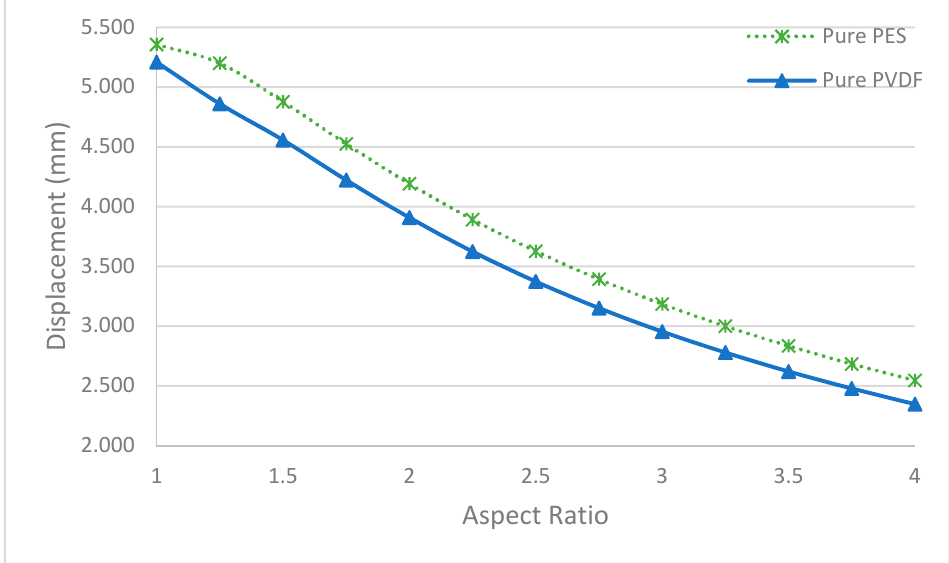
Figure 15. Maximum displacements of pure membranes with different aspect ratios.